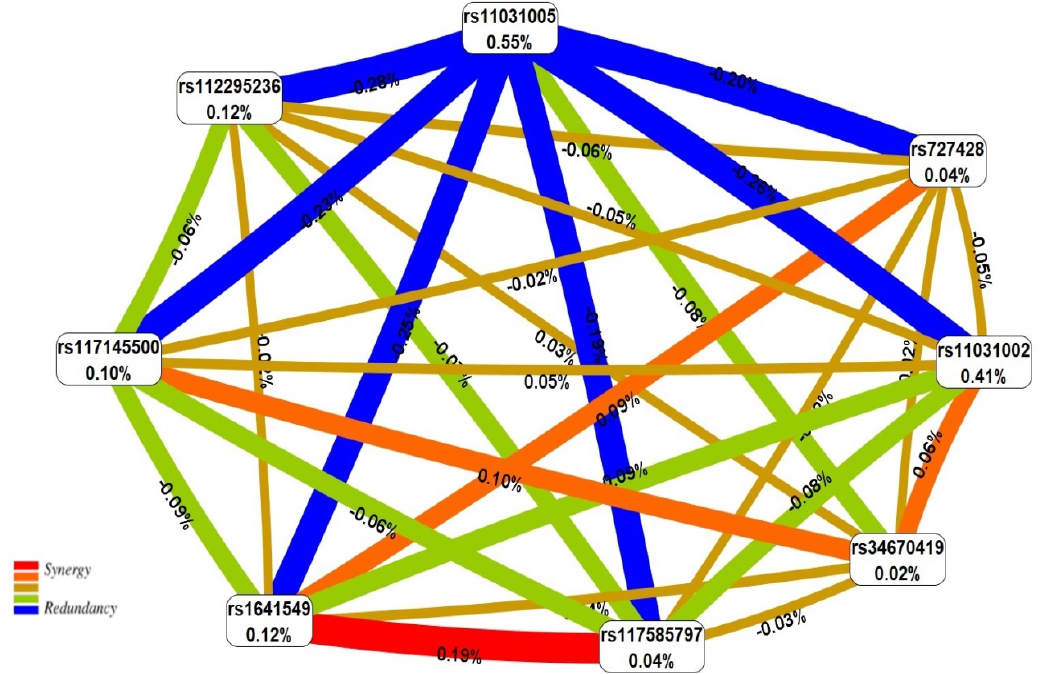
Figure 1. The entropy graph of the SNP × SNP interactions in endometriosis based on the MDR analysis. Positive values of entropy indicate synergistic interactions, while negative values indicate redundancy. The red and orange colors denote strong and moderate synergism, respectively; brown color denotes an independent effect; and green and blue colors denote moderate and strong antagonism, respectively.